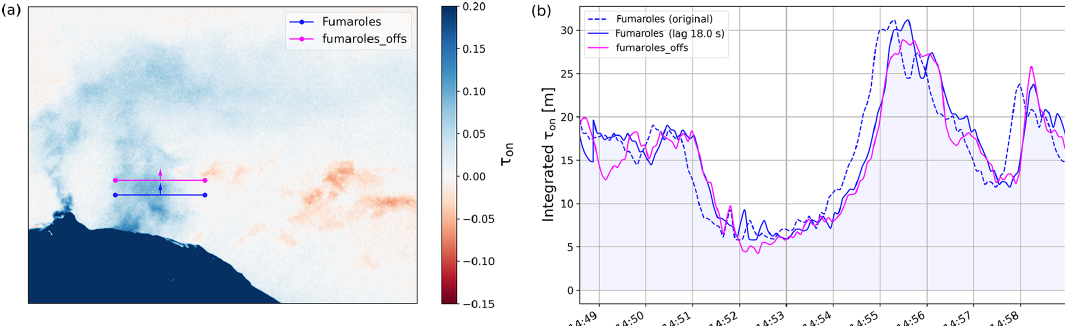
Figure B3. Result of velocity cross-correlation analysis for the Guallatiri data. (a) Example plume on-band OD image ( τ on ) including the PCS (blue) and offset line (magenta) used for the analysis. (b) Corresponding time series of integrated on-band ODs (dashed blue and magenta), and further, the shifted PCS signal corresponding to the retrieved correlation lag of 18.0 s (solid blue). Note that here, the velocity analysis was applied using a time series of on-band OD images rather than the τ AA which was used in Fig. B2.